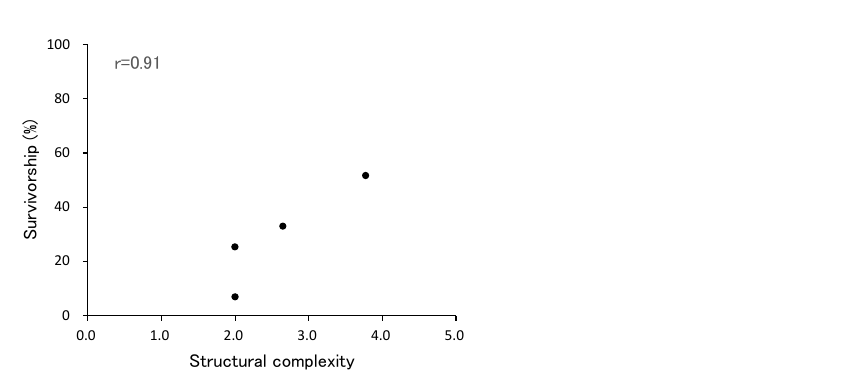
Figure 6. Correlation between post-settlement survivorship and structural complexity in the sub- strata.